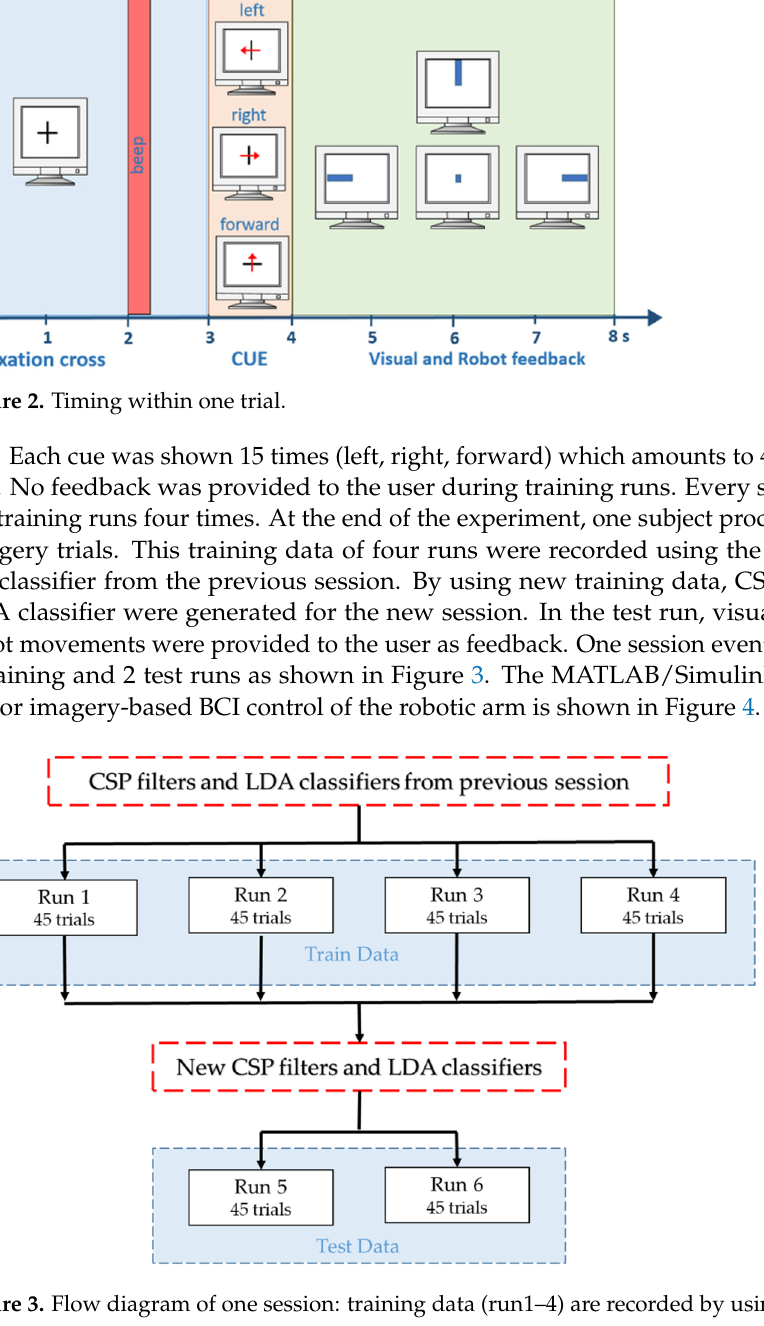
Figure 4. Motor imagery-based BCI model to control a robot arm. 2.3. Feature Extraction and Classification The common spatial patterns (CSP) method is a frequently used algorithm for Motor Imagery discrimination tasks. It uses covariance to design common spatial patterns and is based on the simultaneous diagonalization of two covariance matrices [16]. The method maximizes the variance for one class while minimizing it for the other one [34]. By doing so, the difference between the populations of the two classes is maximized, and the only information contained in these patterns is where the variance of the EEG varies most when compared to the two conditions. Considering the N number of EEG channels for each class 1 and class 2 and T samples for each channel, the dimension of the data matrix is N × T. The normalized covariance matrix for each class is: